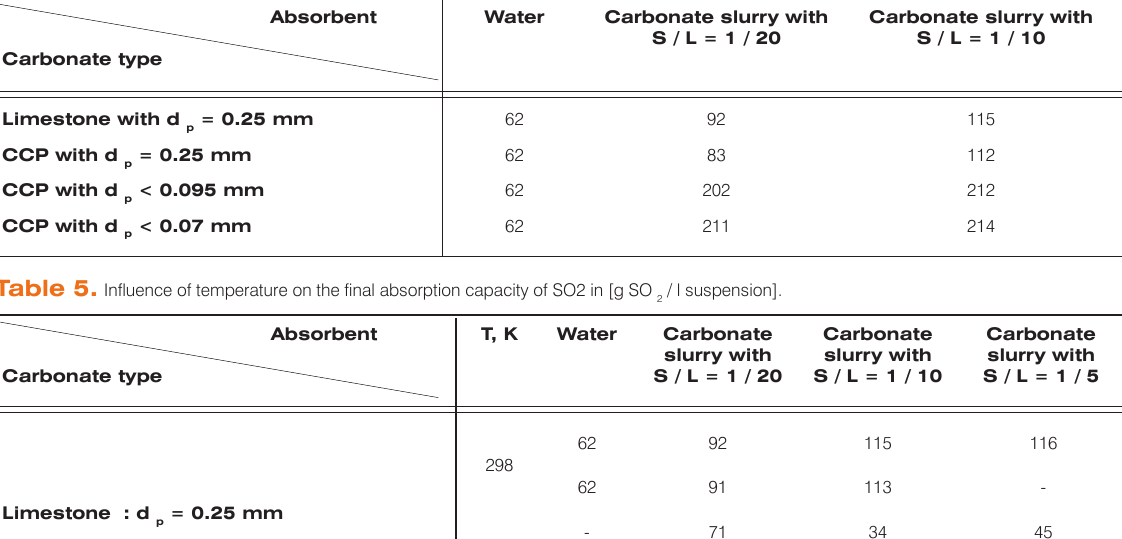
/ l suspension] at T = 298 K. 2